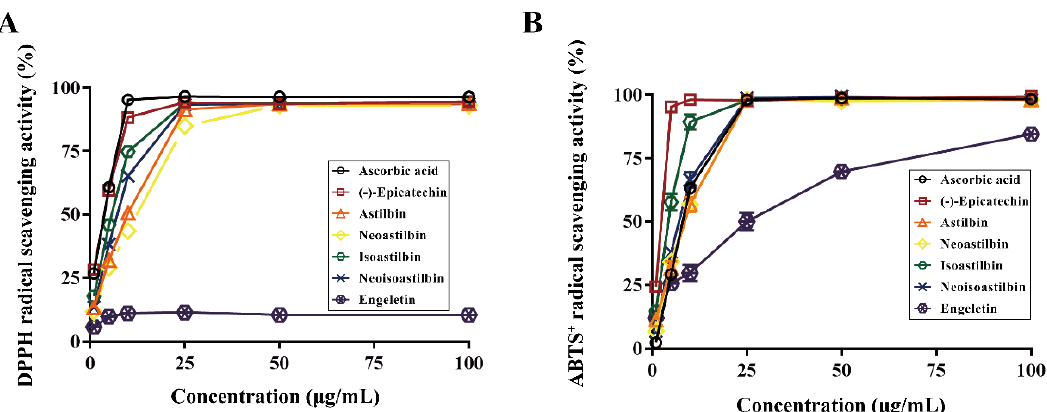
Figure 4. 2,2-Diphenyl-1-picrylhydrazyl ( DPPH) radical scavenging activity ( A ) and 2,2 ′ -Azinobis (3-ethylbenzothiazoline-6-sulphonic acid) diammonium salt (ABTS + ) radical scavenging activity ( B ) of six flavonoids in Smilax glabra flavonoids extract (SGF). Data are expressed as means ± SD ( n = 3). Table 1. IC 50 of DPPH and ABTS + radicals scavenging activity and FRAP values of six flavonoids in Smilax glabra flavonoids extract (SGF). Ascorbic ( − )-Epicatechin Astilbin Neoastilbin Isoastilbin Acid